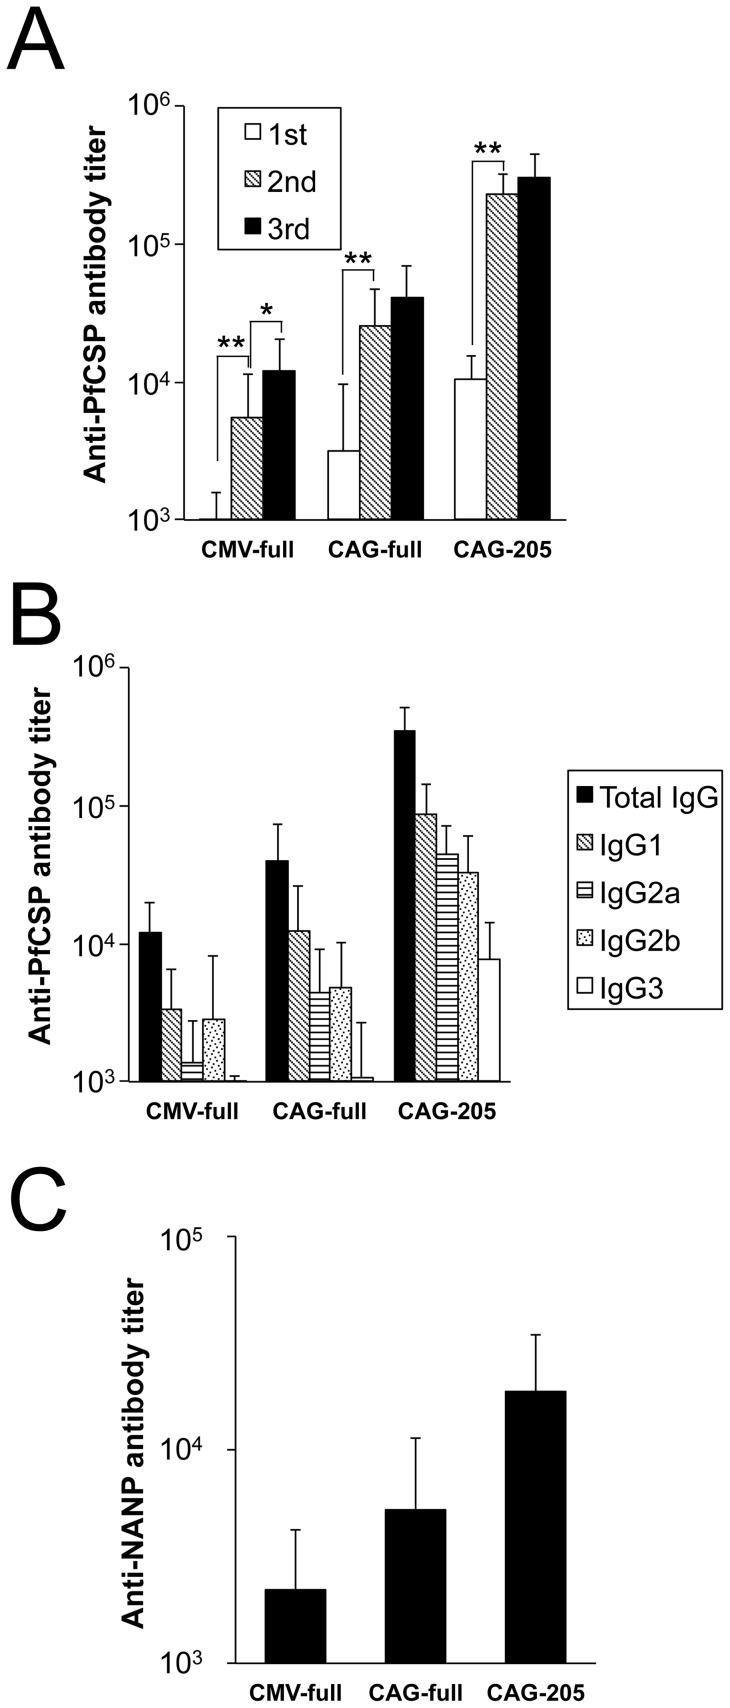
Kinetics of anti-PfCSP humoral immune responses.Groups of mice were injected with PBS or immunized intramuscularly with CMV-full, CAG-full or CAG-205 (n = 10). (A) Sera were collected from the immunized mice 3 weeks after the first and second immunizations and 2 weeks after the last immunization. Bars and error bars indicate the mean and SD of the values, respectively. Significant differences in each immunization group were evaluated using Student's t-tests. * p<0.05; ** p<0.01. (B) Individual sera after the last immunization were tested for total IgG, IgG1, IgG2a, IgG2b and IgG3 specific to PfCSP by ELISA. (C) Ab titers against the PfCSP NANP repeats in the sera after the last immunization. Statistically significant differences for each Ab titer among the three immunized groups were evaluated using the Kruskal-Wallis non-parametric tests (p<0.001). Data are representative of 3 independent experiments.